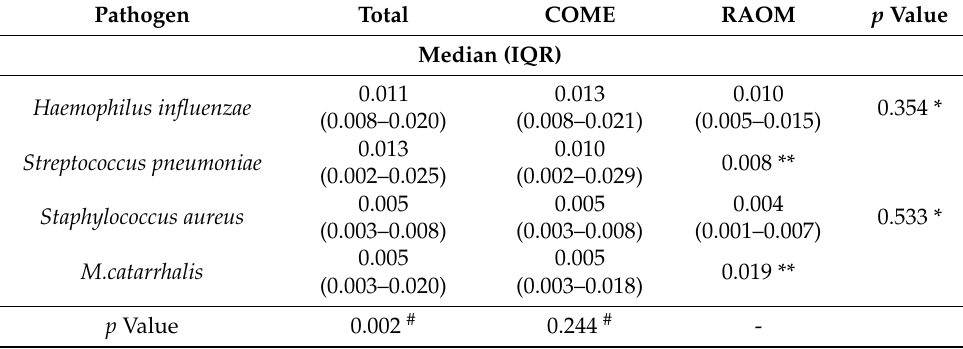
Table 3. Biofilm weight differences among COME and RAOM